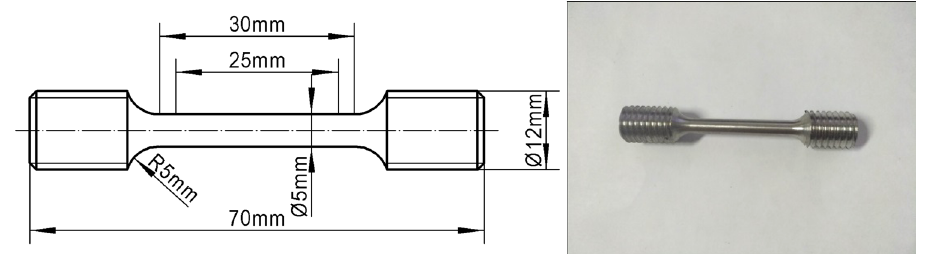
Figure 4: The shape and size of the tensile